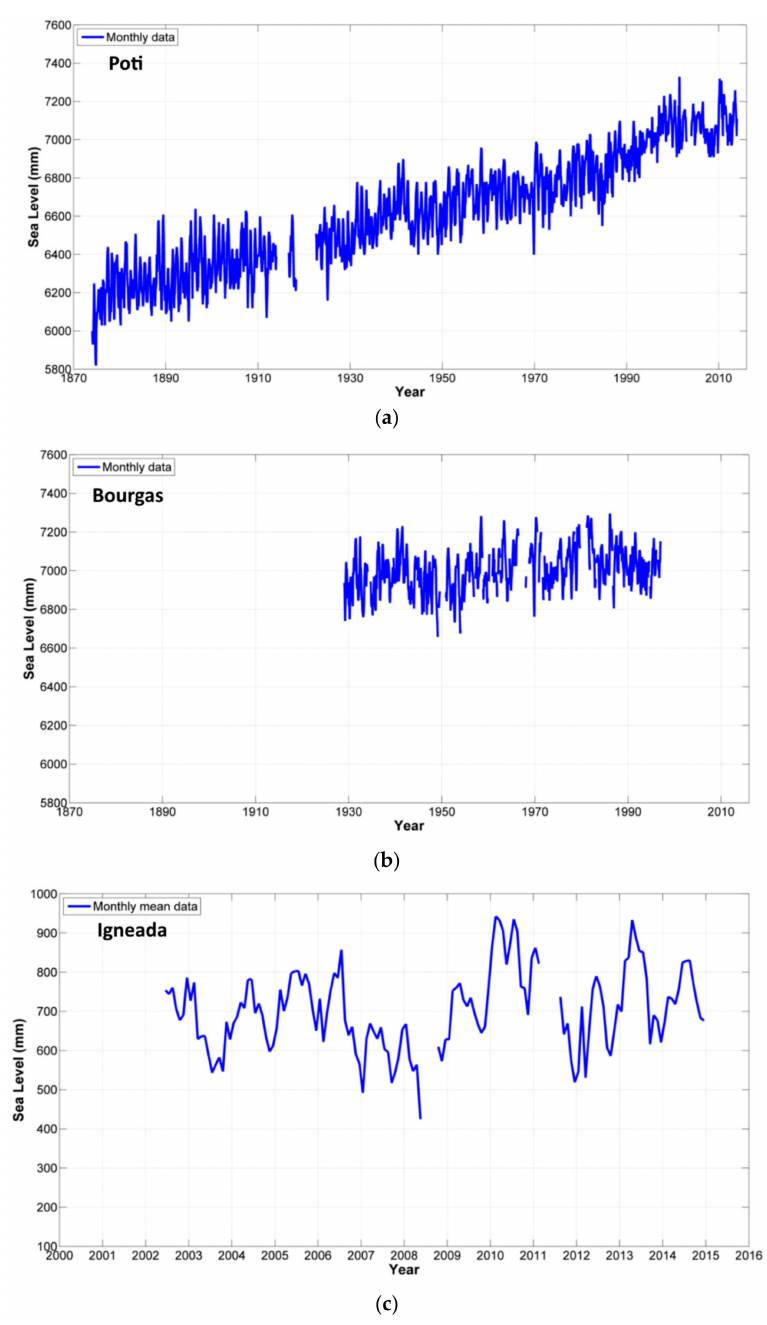
Figure 4. Three examples of the relative mean sea level changes at tide gauge stations along the Black Sea coast: ( a ) Poti from the Permanent Service for Mean Sea Level (PSMSL); ( b ) Bourgas from the PSMSL; ( c ) Igneada from the Turkish National Sea Level Monitoring System